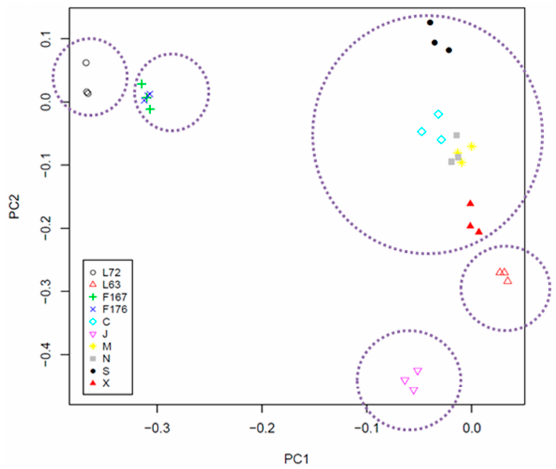
Figure 2. Ten chicken lines were grouped into different clusters in this heatmap plot based on CNV segment mean values (the average log 2 Ratio values). These results revealed three samples from the same lines were always clustered together in the same branches. As expected, F1 individuals branched in an intermediary position between Line 72 and Line 63.